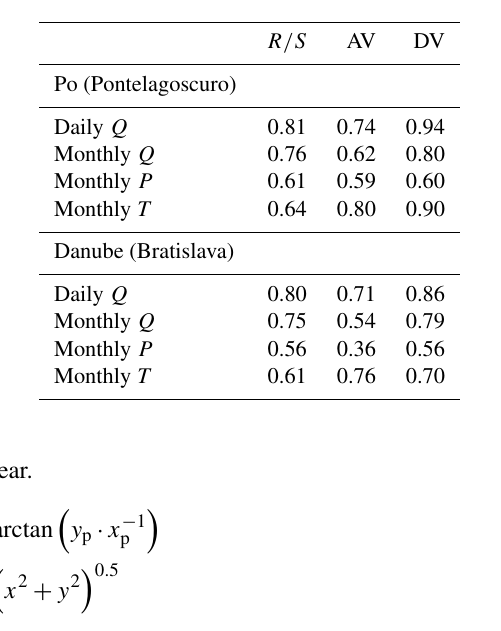
Table 2. Estimated H values on deseasonalized data series apply- ing the R/S statistic ( R/S ), aggregated variance method (AV), and differenced variance method